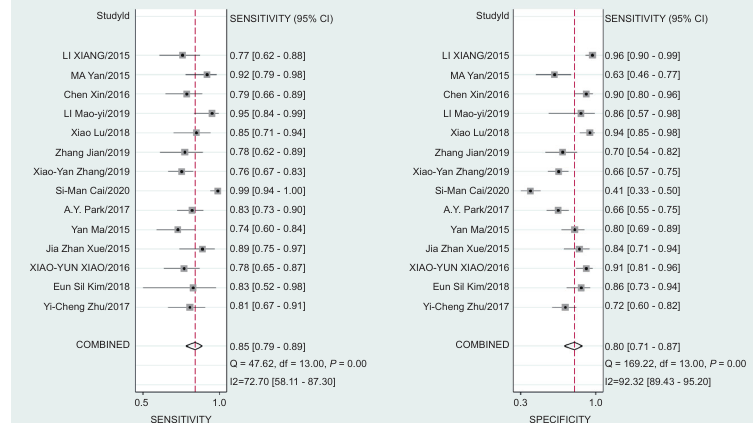
Figure 3 The forest plots of the pooled sensitivity and specificity of SMI to distinguish breast masses. CI: confidence interval.